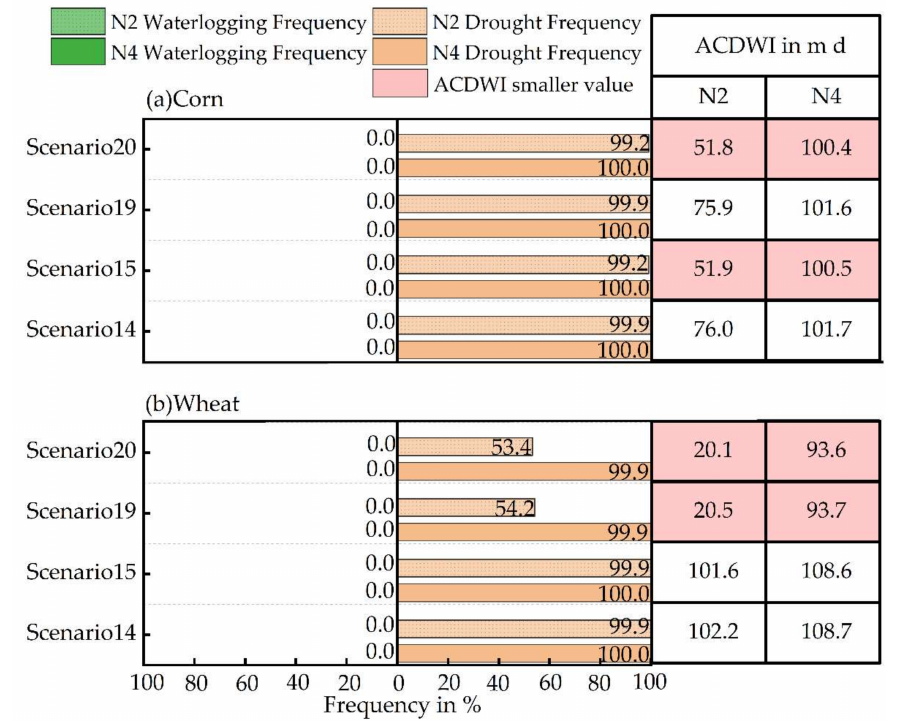
Figure 7. Drought and waterlogging stresses under different ditches’ water-depth scenarios in the northern section from 1989 to 2019, ( a ) corn growth period, ( b ) wheat growth period.